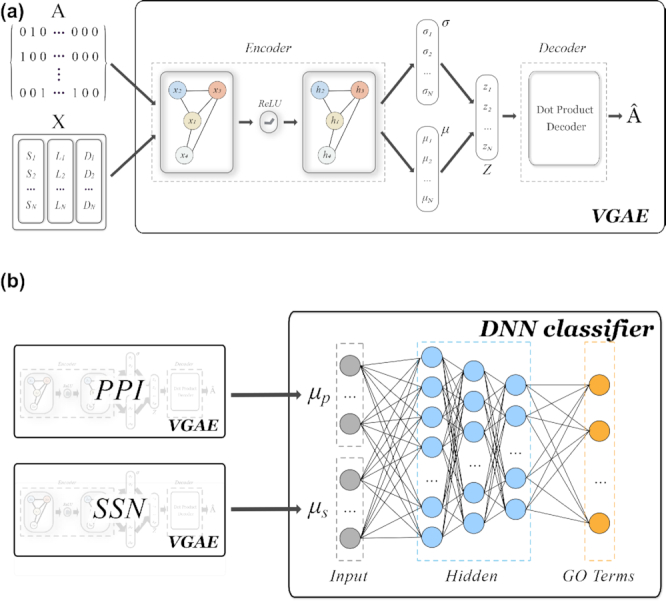
(a) Architecture of the variational graph auto encoder (VGAE), the first part of Graph2GO. The inputs to VGAE include an adjacency matrix A, representing a protein-related network, and a node attribute matrix. VGAE is an encoder-decoder approach. The encoder is a two-layer graph convolutional network and the decoder is a dot product decoder. The mean vector, \documentclass[12pt]{minimal}
\usepackage{amsmath}
\usepackage{wasysym}
\usepackage{amsfonts}
\usepackage{amssymb}
\usepackage{amsbsy}
\usepackage{upgreek}
\usepackage{mathrsfs}
\setlength{\oddsidemargin}{-69pt}
\begin{document}
}{}$\boldsymbol {\mathrm{\mu }}_i$\end{document}, is the output embedding for classification. (b) Graph2GO pipeline consisting of two VGAE models for PPI networks and SSN respectively, and the final DNN classifier. The two embeddings generated from the PPI network and SSN are concatenated as the input for the DNN classifier, and the DNN classifier outputs the probabilities of the protein having each GO term annotation.